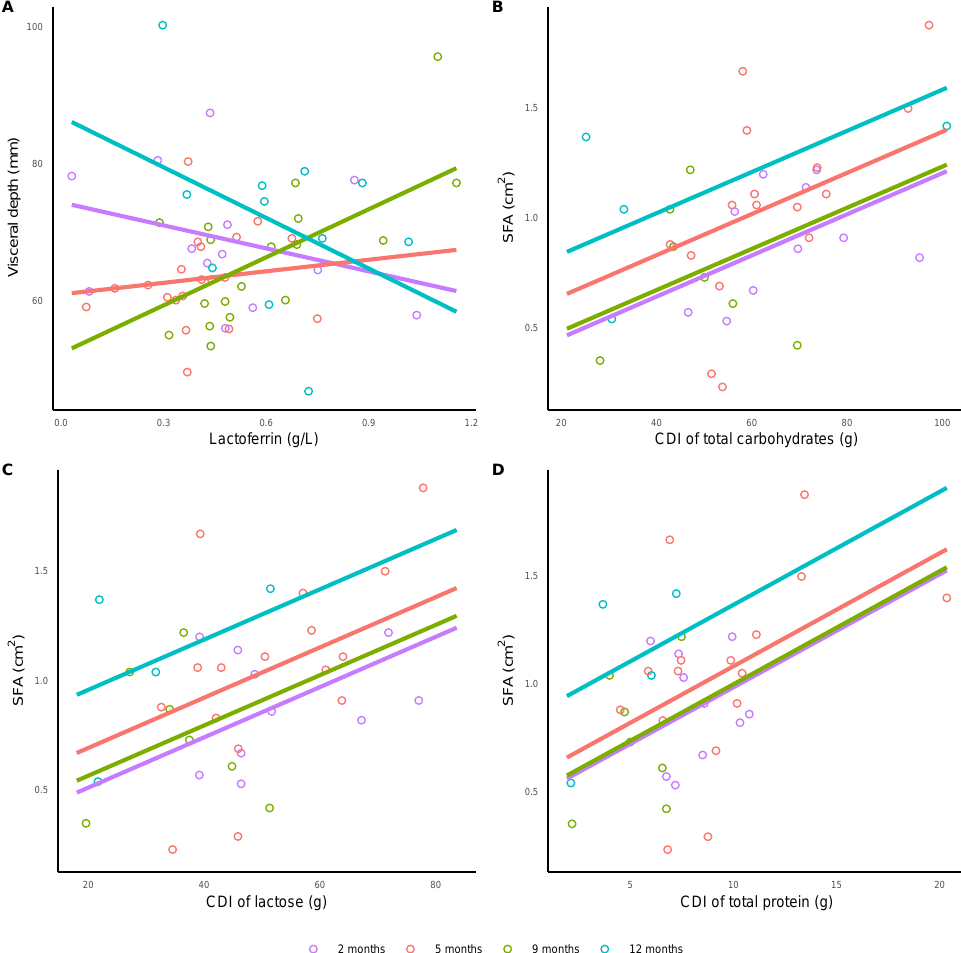
Figure 1. Significant associations between ( A ) infant visceral depth and lactoferrin concentration ( p = 0.003); and infant subcutaneous fat area (SFA) and calculated daily intakes (CDI) of ( B ) total carbohydrates ( p = 0.004), ( C ) lactose ( p = 0.013) and ( D ) total protein ( p = 0.013). Lines represent linear regression and grouped by the month of lactation. CDI of total protein ( p = 0.013), total carbohydrates ( p = 0.004) and lactose ( p = 0.013) were positively associated with infant SFA (Table 2, Figure